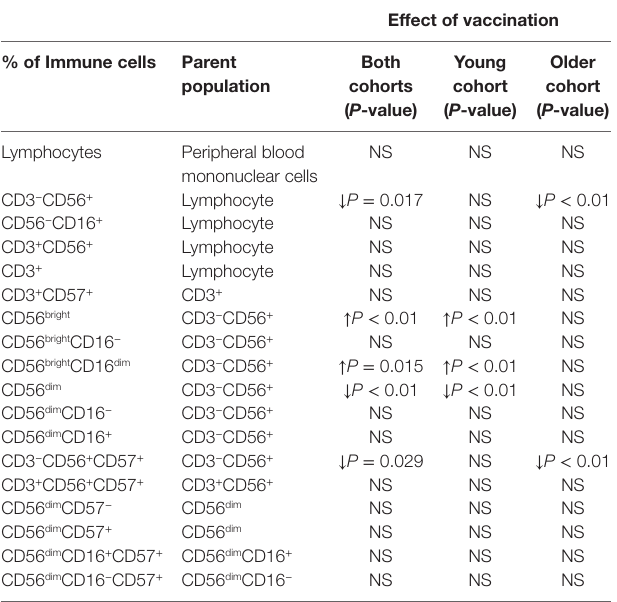
TaBlE 3 | Changes in natural killer cell phenotype following influenza vaccination in young and older